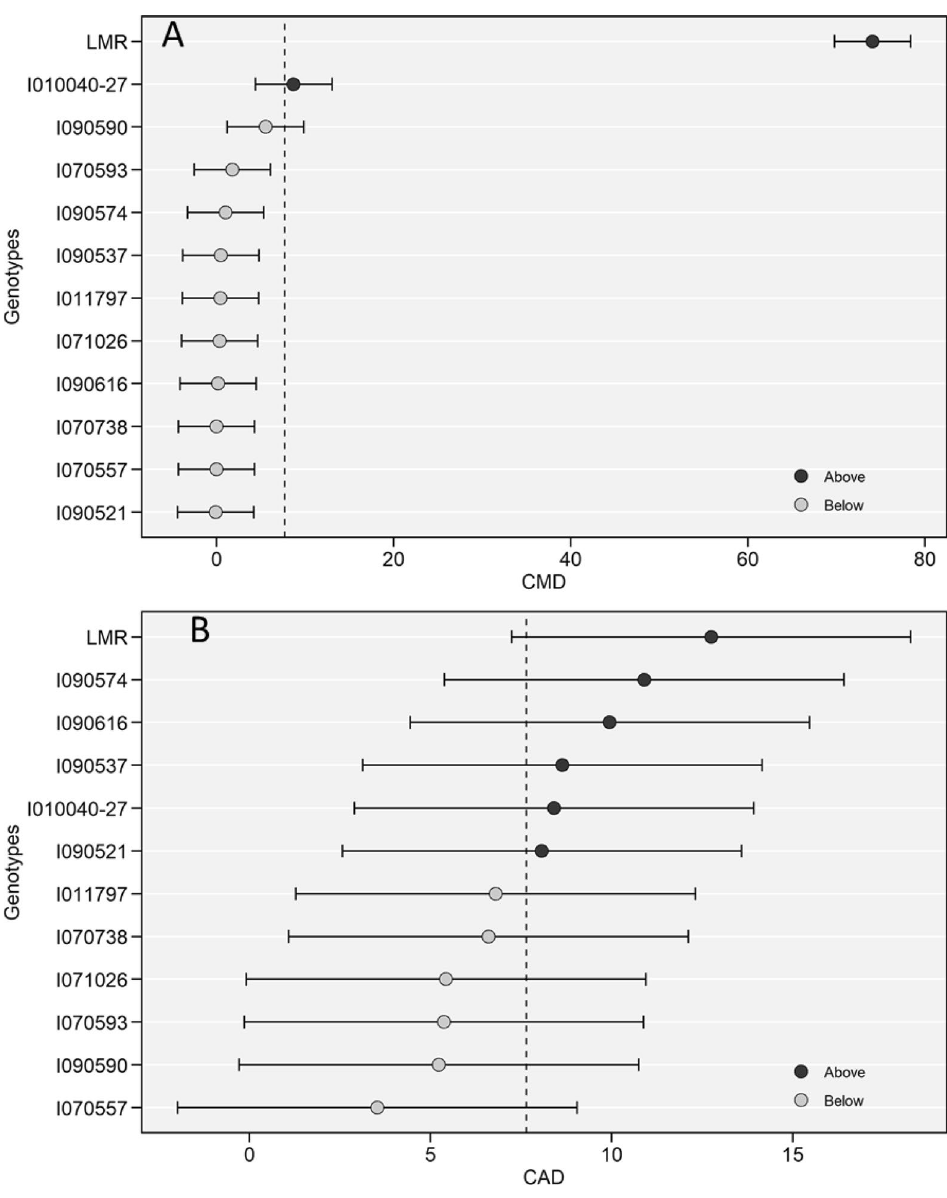
Figure 1. Best linear unbiased prediction of CMD ( A ) and CAD ( B ) incidence (%) for 12 cassava genotypes. Black and grey circles represent the genotypes that had BLUP above and below of BLUP mean, respectively. Horizontal error bars represent the 95% confidence interval of a prediction considering a 2-tailed t test. (R V3.6.2, https:// cran.r- proje ct. org/ web/ packa ges/